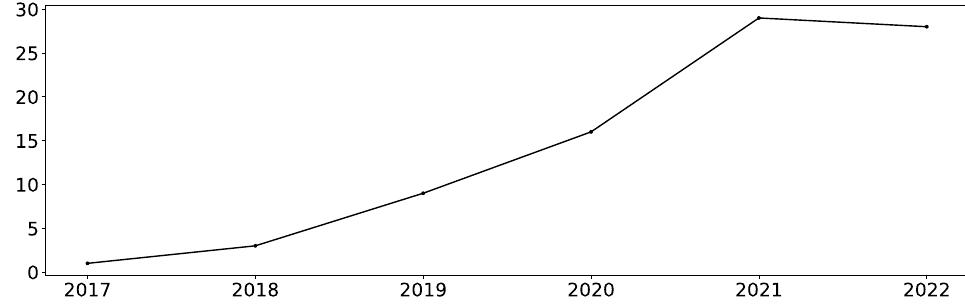
Figure 1. Bit-flip attack and defense related works in recent years.